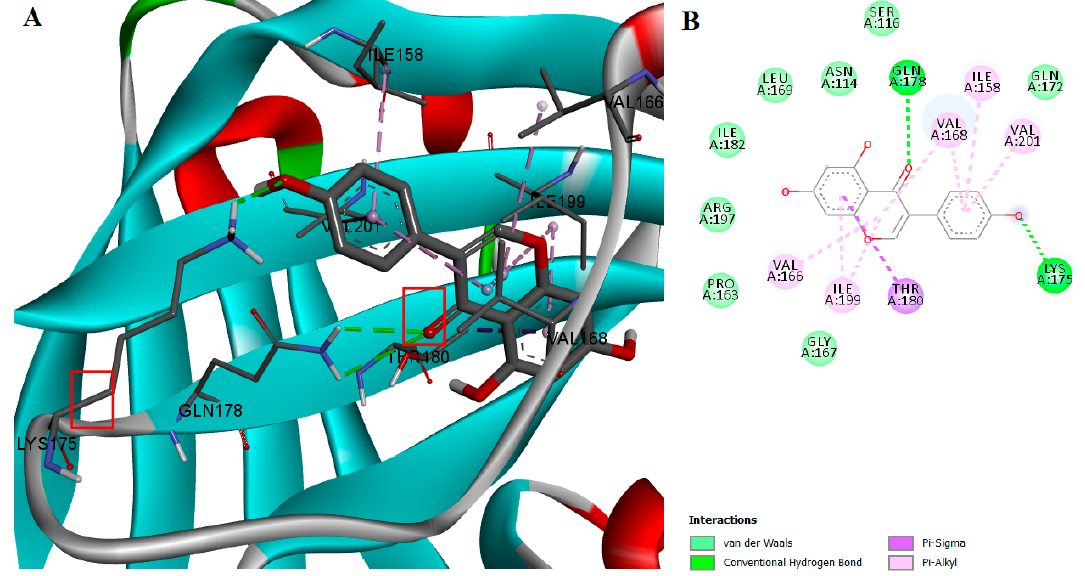
Figure 2. ( A ) Docked conformation and interactions of the genistein-SrtA complex; ( B ) 2D diagram of the predicted interactions; backbone of the protein is colored in grey, β -helices in turquoise, α -helices in red and loops in green. Ligand-protein interactions are colored depending on their type: conventional hydrogen bonds are colored in green, π - σ and π -alkyl interactions are colored in purple and light purple, respectively.